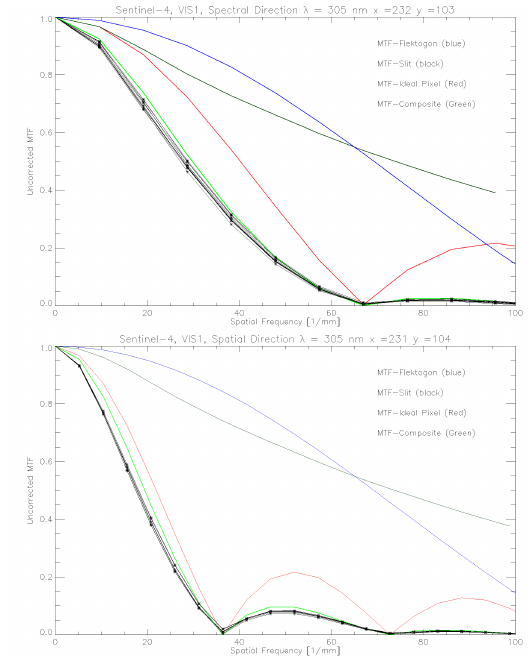
Figure 12. Uncorrected MTF (at 305 nm ) in comparison to theoretical influences. Spectral diection (upper image, 15 µm ) and spatial direction (lower image 27 . 5 µm ).